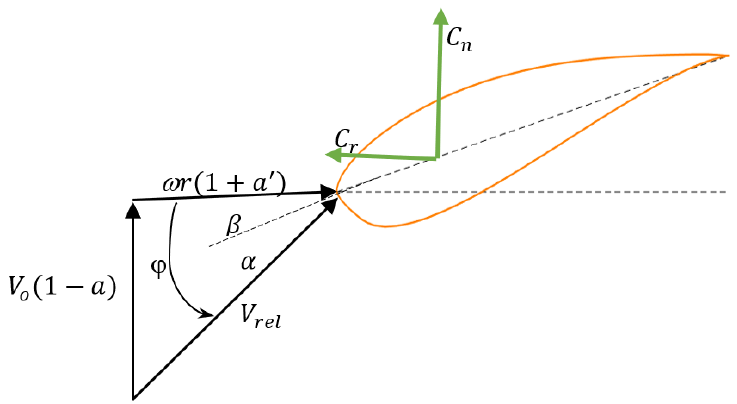
Figure 4. Representation and relationships of aerodynamic forces, velocities, and angles.